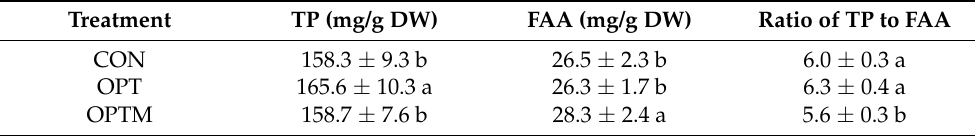
Data are means ± SD (n = 5). DW = Dry weight. Different upper letters within the same column indicated a significant difference between treatments at p < 0.05 by one-way ANOVA analysis. CON, conventional fertilization; OPT, optimized fertilization; OPTM, optimized fertilization supplemented with